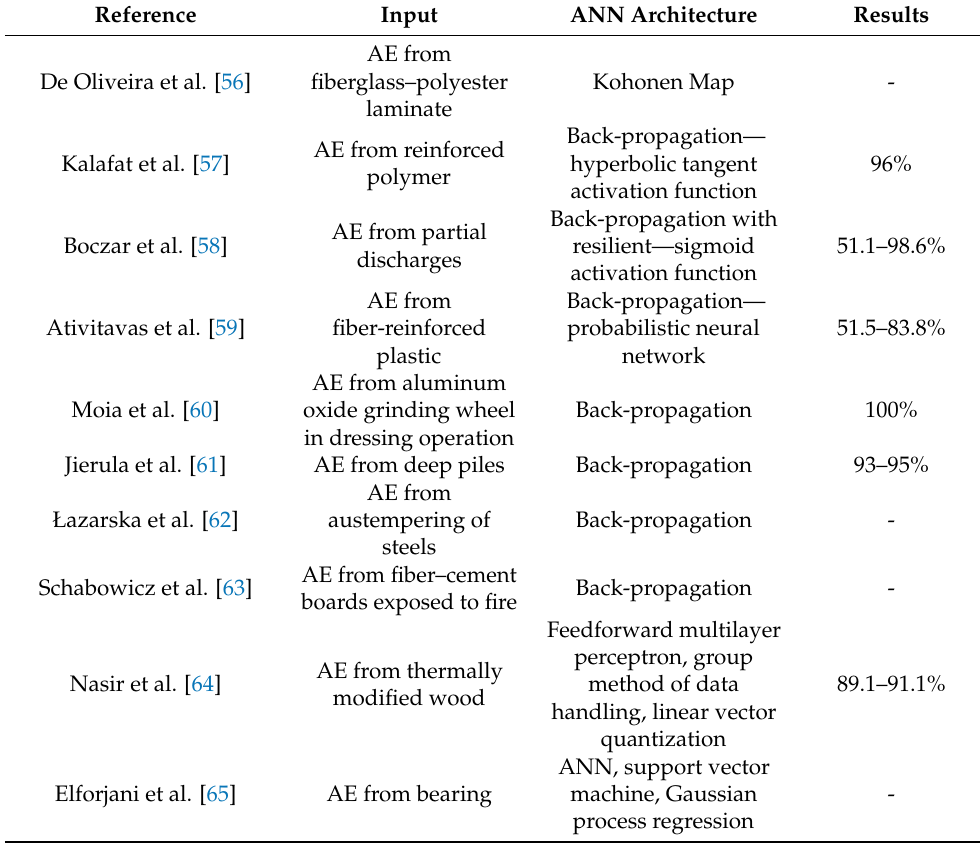
Table 2. ANN-based methods for